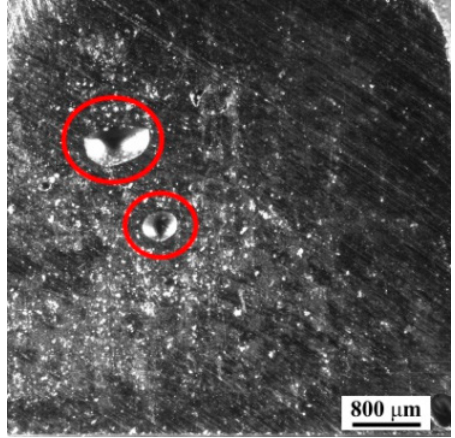
Figure 9. Porosity (keyholes) in the samples without US.